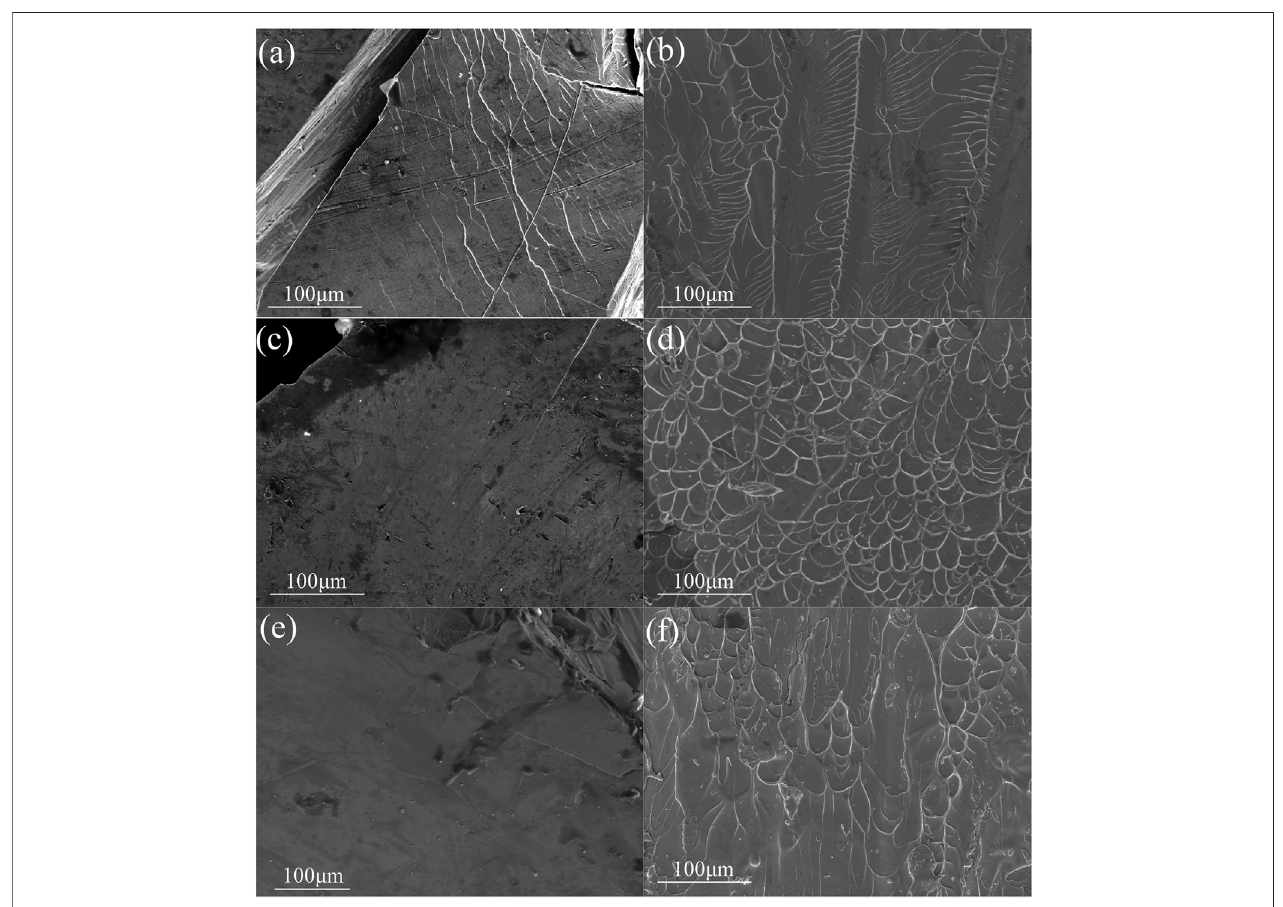
FIGURE 3 | SEM images of the samples surfaces and fracture surfaces with diameters of 2 mm [ (A,B) ], 3 mm [ (C,D) ], and 5 mm [ (E,F) ], respectively. In (A) , the shear bands are dense, and the red arrows only point out two types of shear bands. The red arrows in (C) and (E) point out all shear bands.